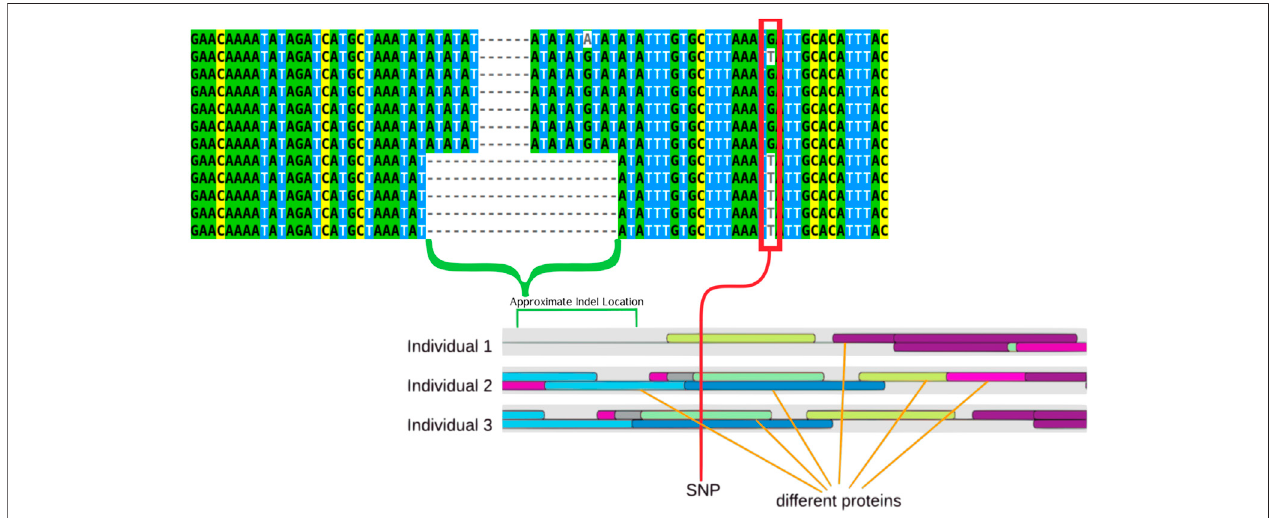
FIGURE 2 | Multiple sequence alignment that displays examples of the two primary genotypes (TT and GG) the larger deletion can be seen tied to the T genotype. The indel is highlighted by a green bracket while a red rectangle highlights the SNPs. These features are also highlight on a drawing that represents the results of the transcription factor binding site prediction. The colored ovals represent different proteins, with three different representative individuals showing how protein binding is predicted differently by the software in different individuals.